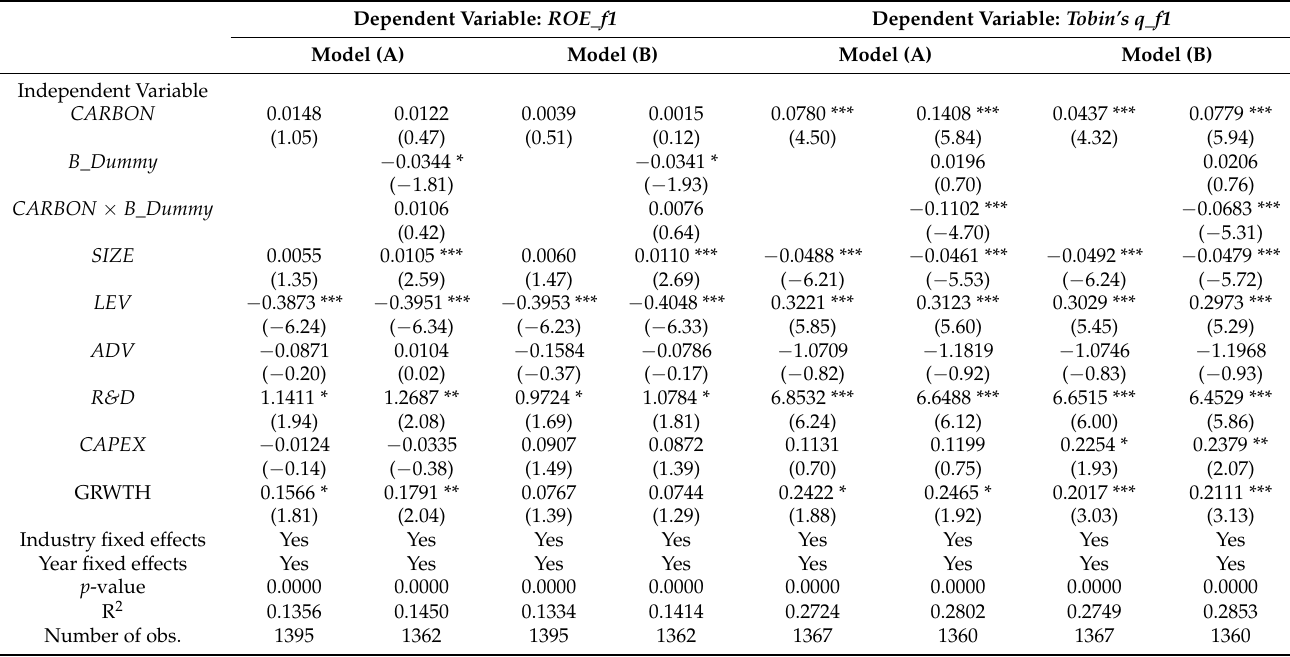
Table 4. Effect of Board Independence on the Relation Between GHG Emissions and Financial Performance.